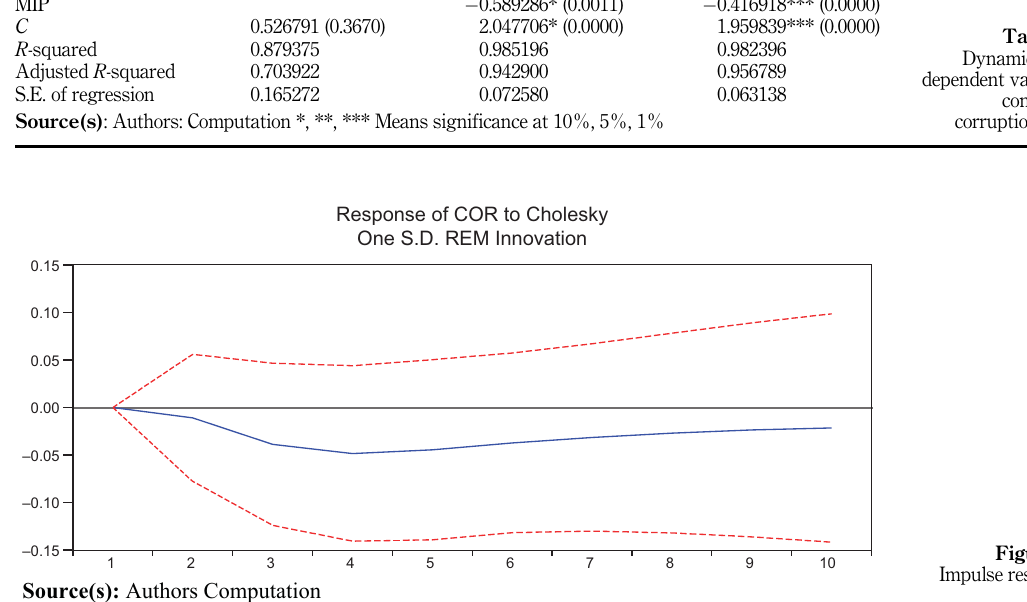
Figure 2. Impulse